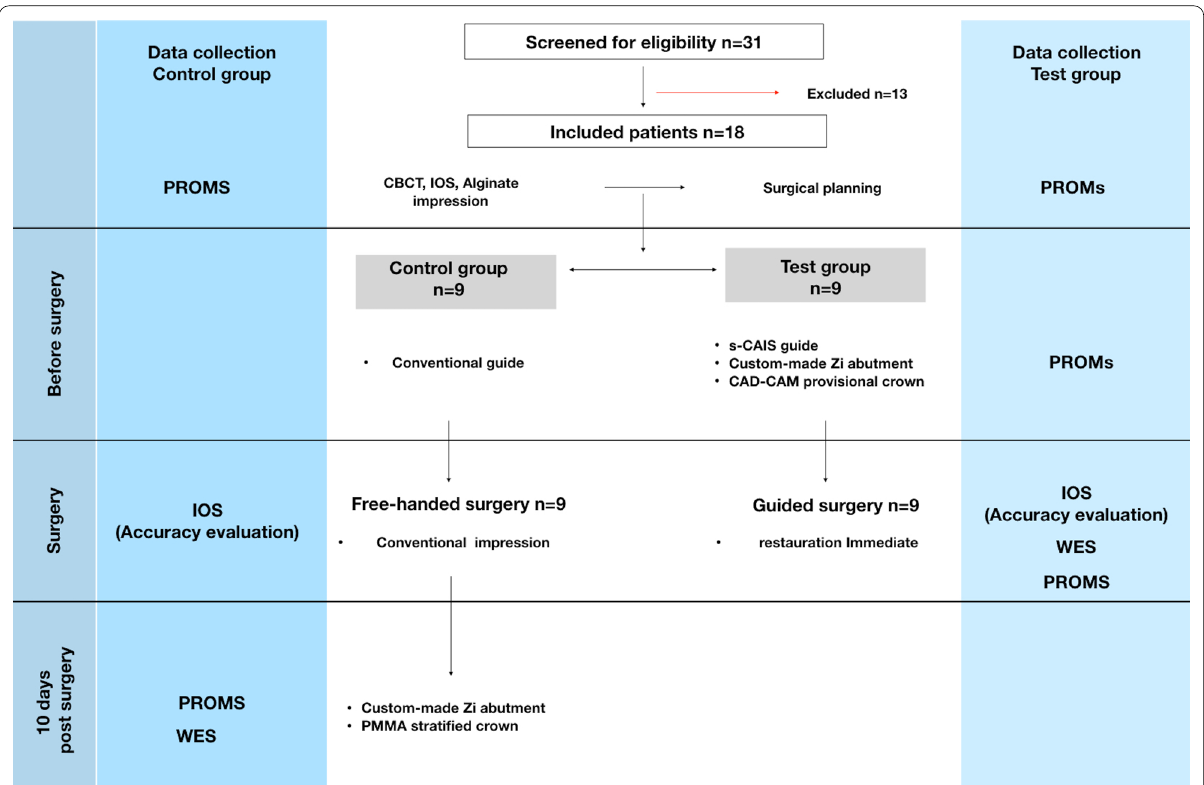
Fig. 2 Study design: Consort flow chart. CBCT cone beam computed tomograpy, WES white esthetic score, PROMs patient-reported outcome measures, IOS intra oral